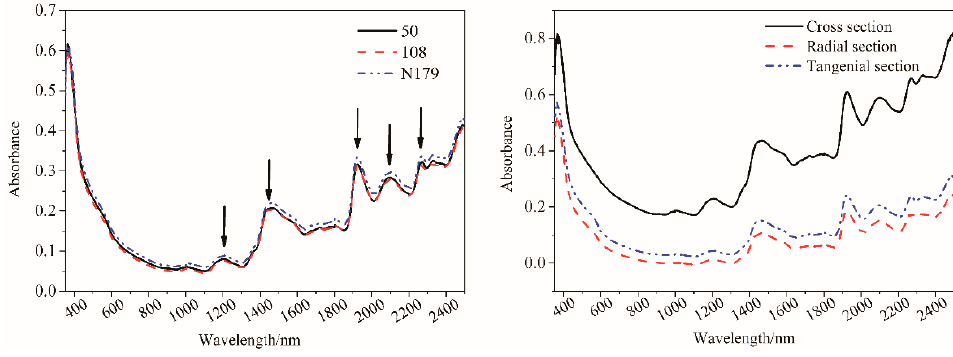
Figure 5. Near infrared spectroscopy (NIR) spectra of three poplar clones and different sections.